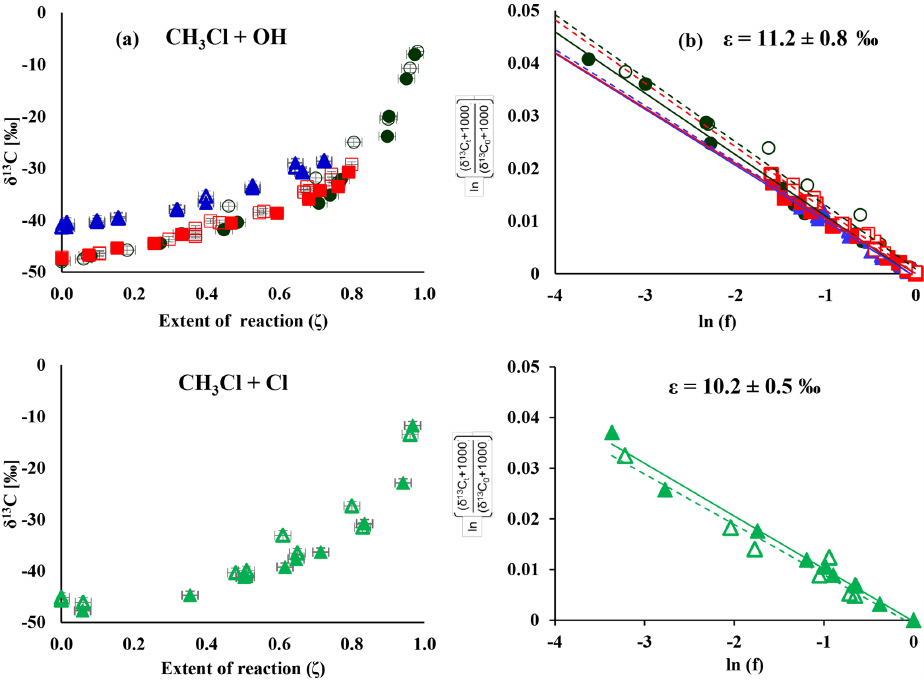
Figure 1. Change in δ 13 C over the extent of the reaction (a) and corresponding Rayleigh plots (b) from the CH 3 Cl degradation experiments. Filled symbols and regression lines refer to the data from Heidelberg; open symbols and dashed regression lines show data from Hamburg. The colours refer to different degradation experiments (black is experiment 1, red is experiment 2, blue is experiment 4 and green is experi- ment 7). Errors in ζ were ± 2% on the 1 σ level. Errors in δ 13 C, derived from the regression analysis, ranged from ± 0 . 4‰ to ± 1 . 4‰ on the 1 σ level. Table 2. Summary of the kinetic isotope effects ( ε ) for the reaction of CH 3 Cl and CH 4 with OH and Cl from this study. We used an orthogonal regression to calculate ε and the respective uncertainties on the 1 σ level for each experiment. In experiment 4 the ε for methane has not been determined. Hamburg